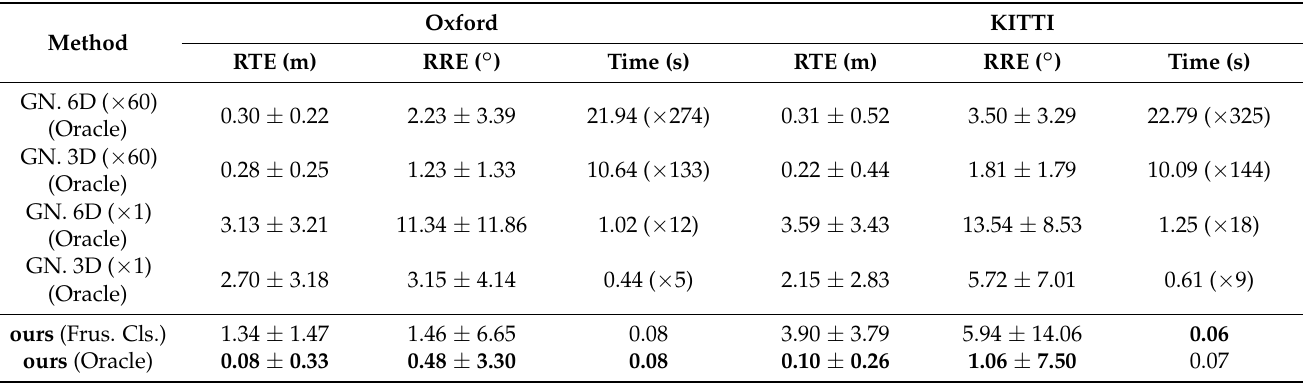
Table 4. Ablation studies. Top performance with correctly provided frustum classification on both Oxford and KITTI datasets. The average value and standard deviation of RTE and RRE as well as the inference time are reported. The notation “Oracle” means that the frustum classification is substituted by ground-truth label in the first classification stage. In contrast, the notation “Frus. Cls.” refers to deep network classification output of